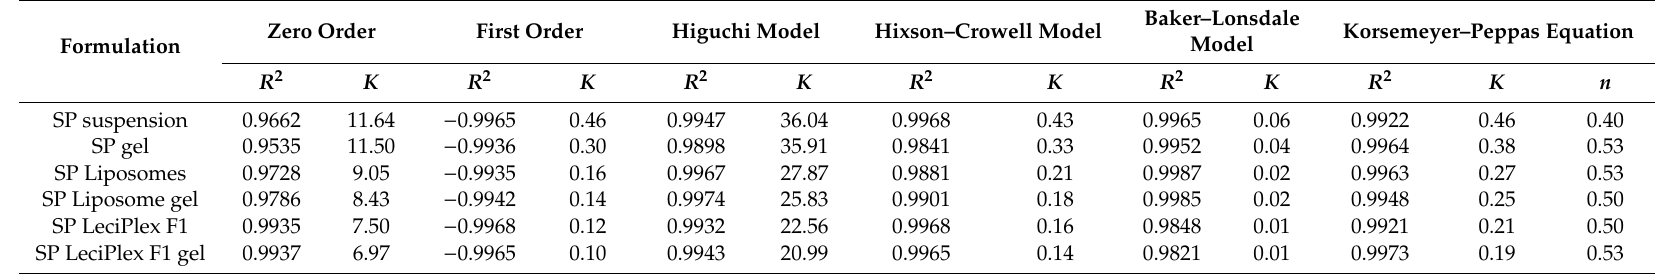
Table 3. Fitting of in vitro release data into di ff erent kinetic